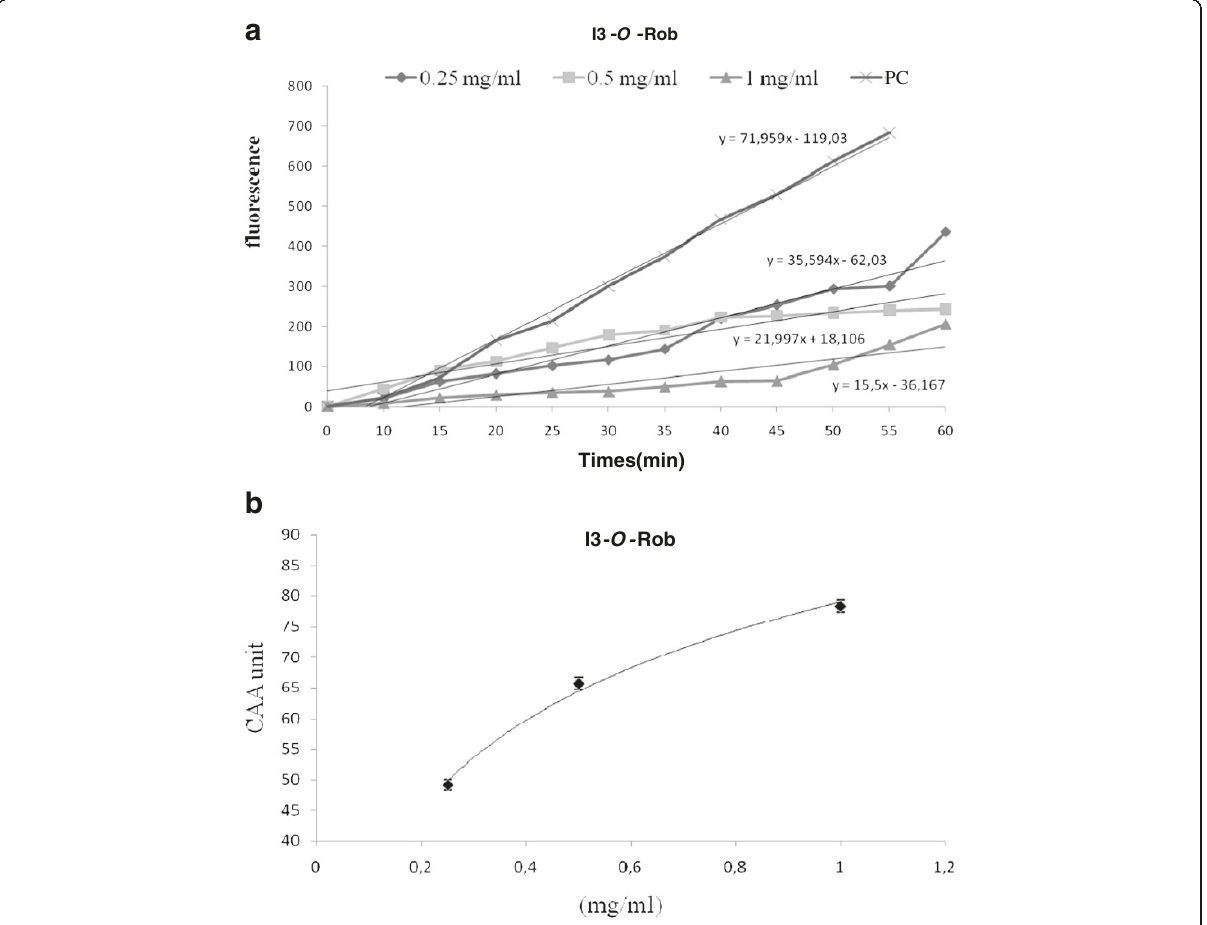
Figure 2 a. Cellular Antioxidant Activity (CAA) of isorhamnetin-3- o - robinobioside (I3- O -Rob) K562 treated cells+2 0 , 7 0 - dichlorofluorescin (DCFH)+2,2 0 -azobis (2-amidinopropane) dihydrochloride (ABAP). PC: Untreated cells+2 0 , 7 0 -dichlorofluorescin (DCFH)+2,2 0 -azobis (2-amidinopropane) dihydrochloride (ABAP). b : Dose – response curve for the inhibition of oxidation of the free-radical 2 0 , 7 0 -dichlorofluorescin (DCFH) to DCF in K562 cells using the cellular antioxidant activity assay in the presence of different concentration of isorhamnetin-3- o -robinobioside (I3- O -Rob) of Nitraria retusa (mean±SD,